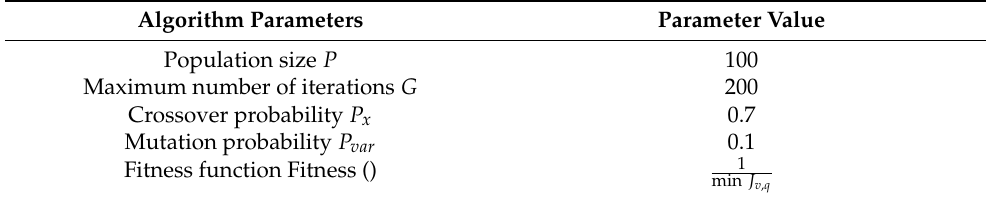
Table 3. Genetic algorithms’ population parameter